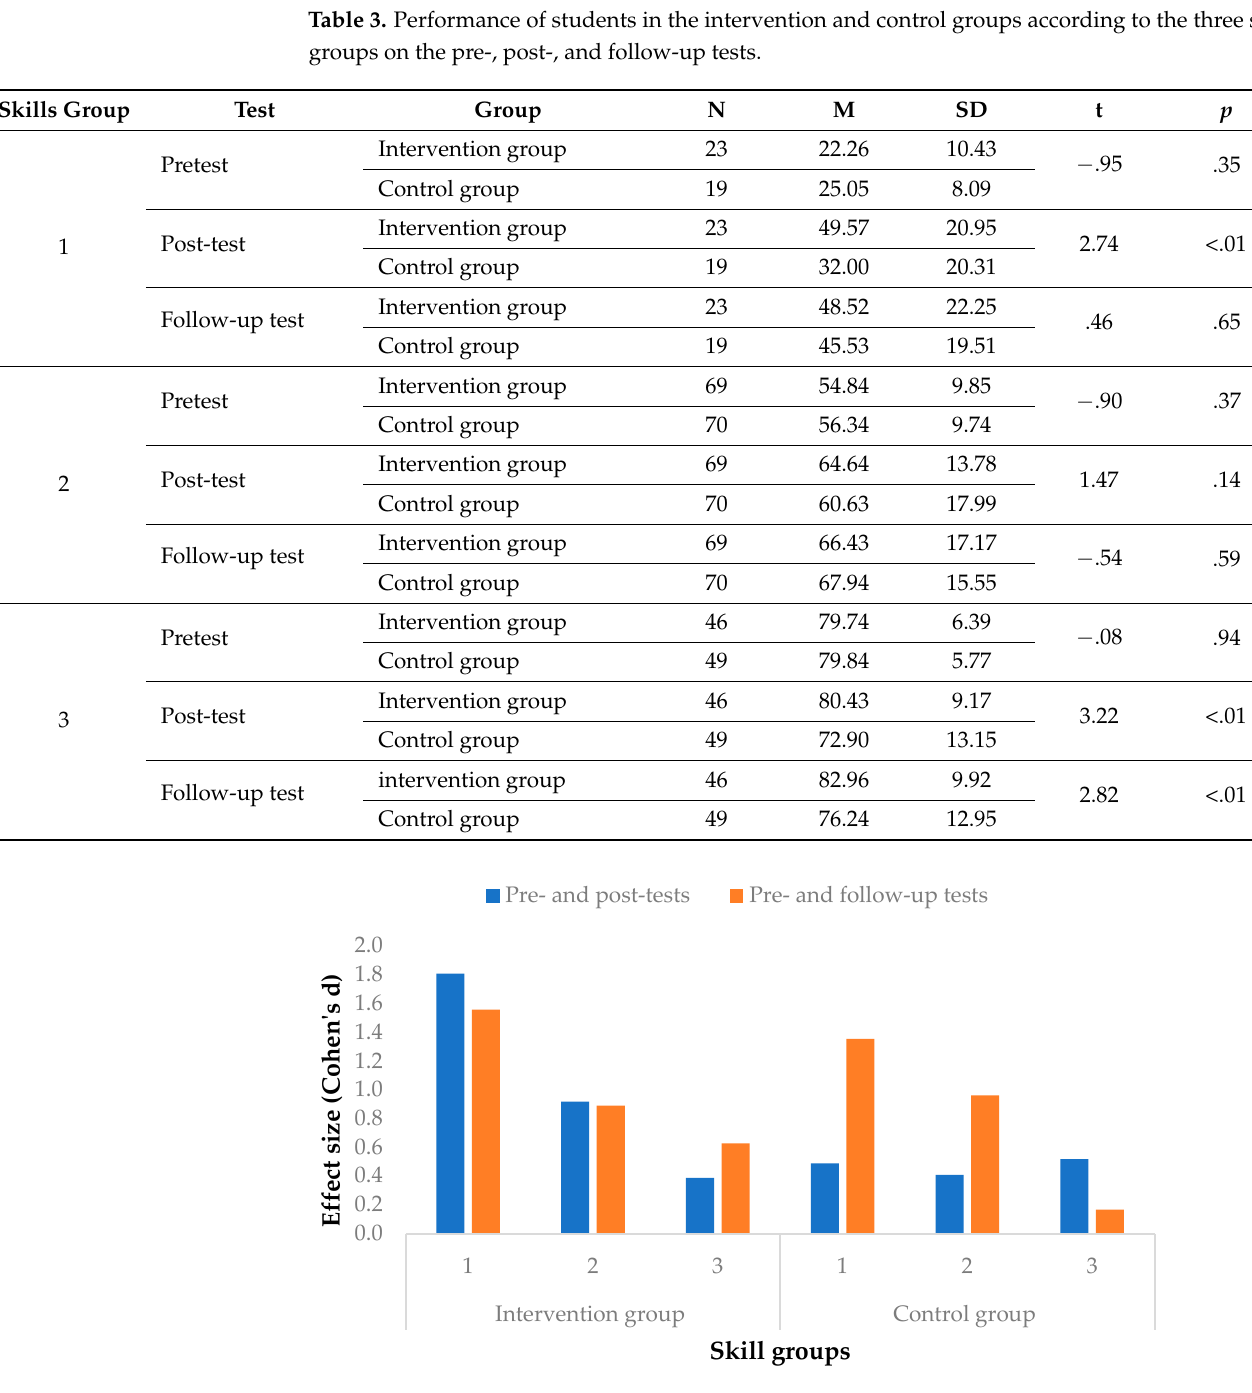
Figure 4. Change in effect size by skill groups in the interventional group and control group. Skill groups (performance on pretest): 1: 0–34%; 2: 35–67%; 3: 68–100%.